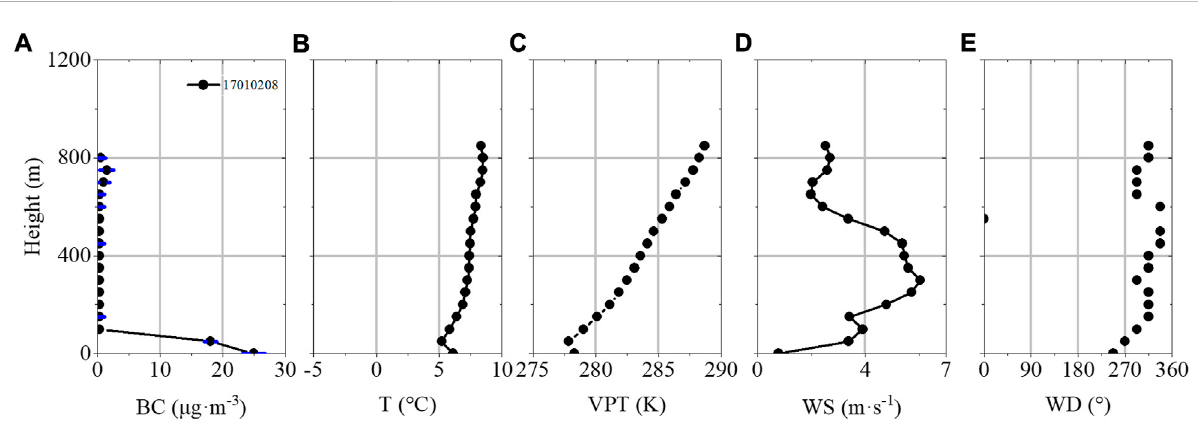
FIGURE 10 Dynamic controlled transformation of stable to unstable boundary BC, T, VPT, WS and WD contours. The black line indicates the contours of eachelementat2017010208.BluelinesareBCerrorbars. (A) blackcarbonaerosolverticalpro fi le, (B) temperatureverticalpro fi le, (C)